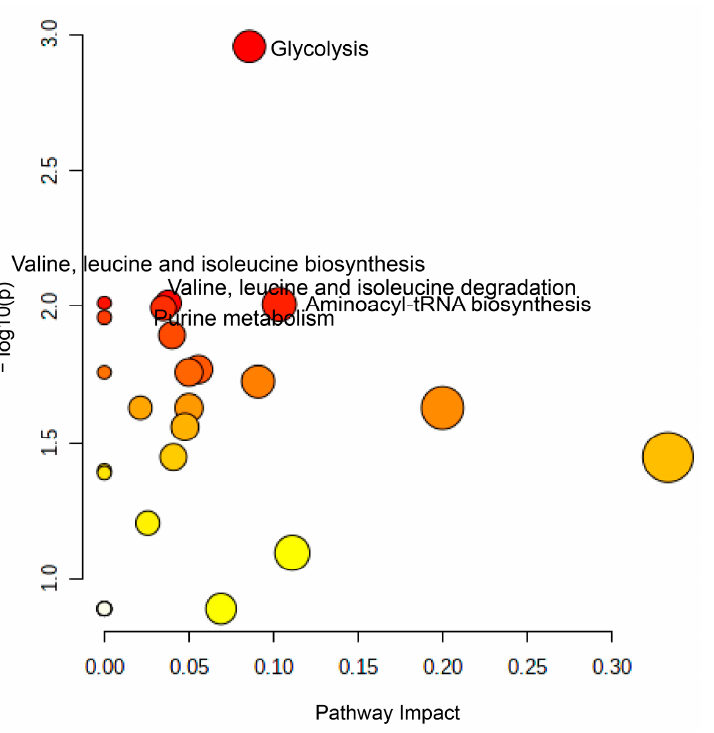
Figure 4. Summary of the pathway analysis results using MetaboAnalyst. The pathway impact ( X -axis) and − log p -value ( Y -axis) were calculated from the pathway topology analysis and pathway enrichment analysis, respectively. Glycolysis, valine, leucine, and isoleucine metabolism (BCAA metabolism), aminoacyl-tRAN biosynthesis, and purine metabolism were significantly different between mice serum for mice administered with standard and fermented lettuce extract (FLE) noodles at a significance level of p < 0.01, with adjusted false discovery rate (FDR) p- value < 0.05.